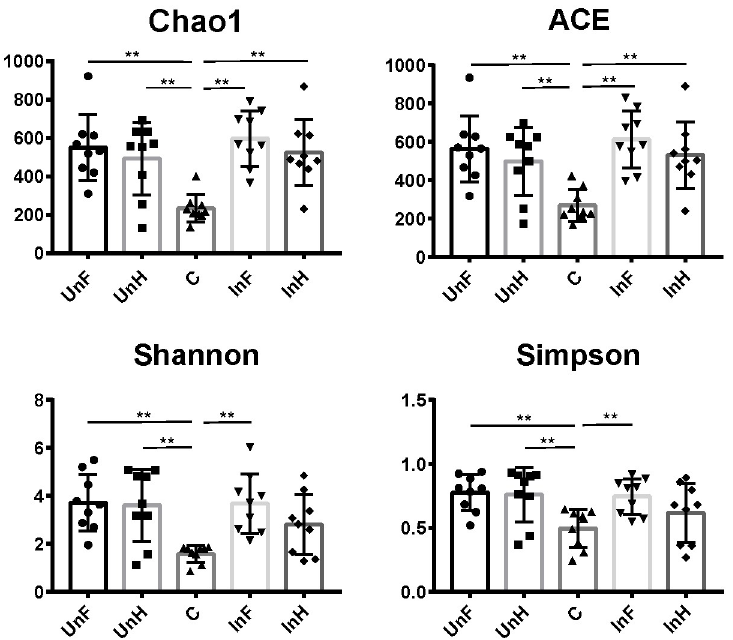
Fig 3. Alpha diversity indices of the gut microbiota of grass carp and on the surface of S . acheilognathi . UnF, uninfected with S . acheilognathi in the foregut of grass carp; UnH, uninfected with S . acheilognathi in the hindgut of grass carp; C, the surface of S . acheilognathi ; InF, infected with S . acheilognathi in the foregut of grass carp; InH, infected with S . acheilognathi in the hindgut of grass carp.